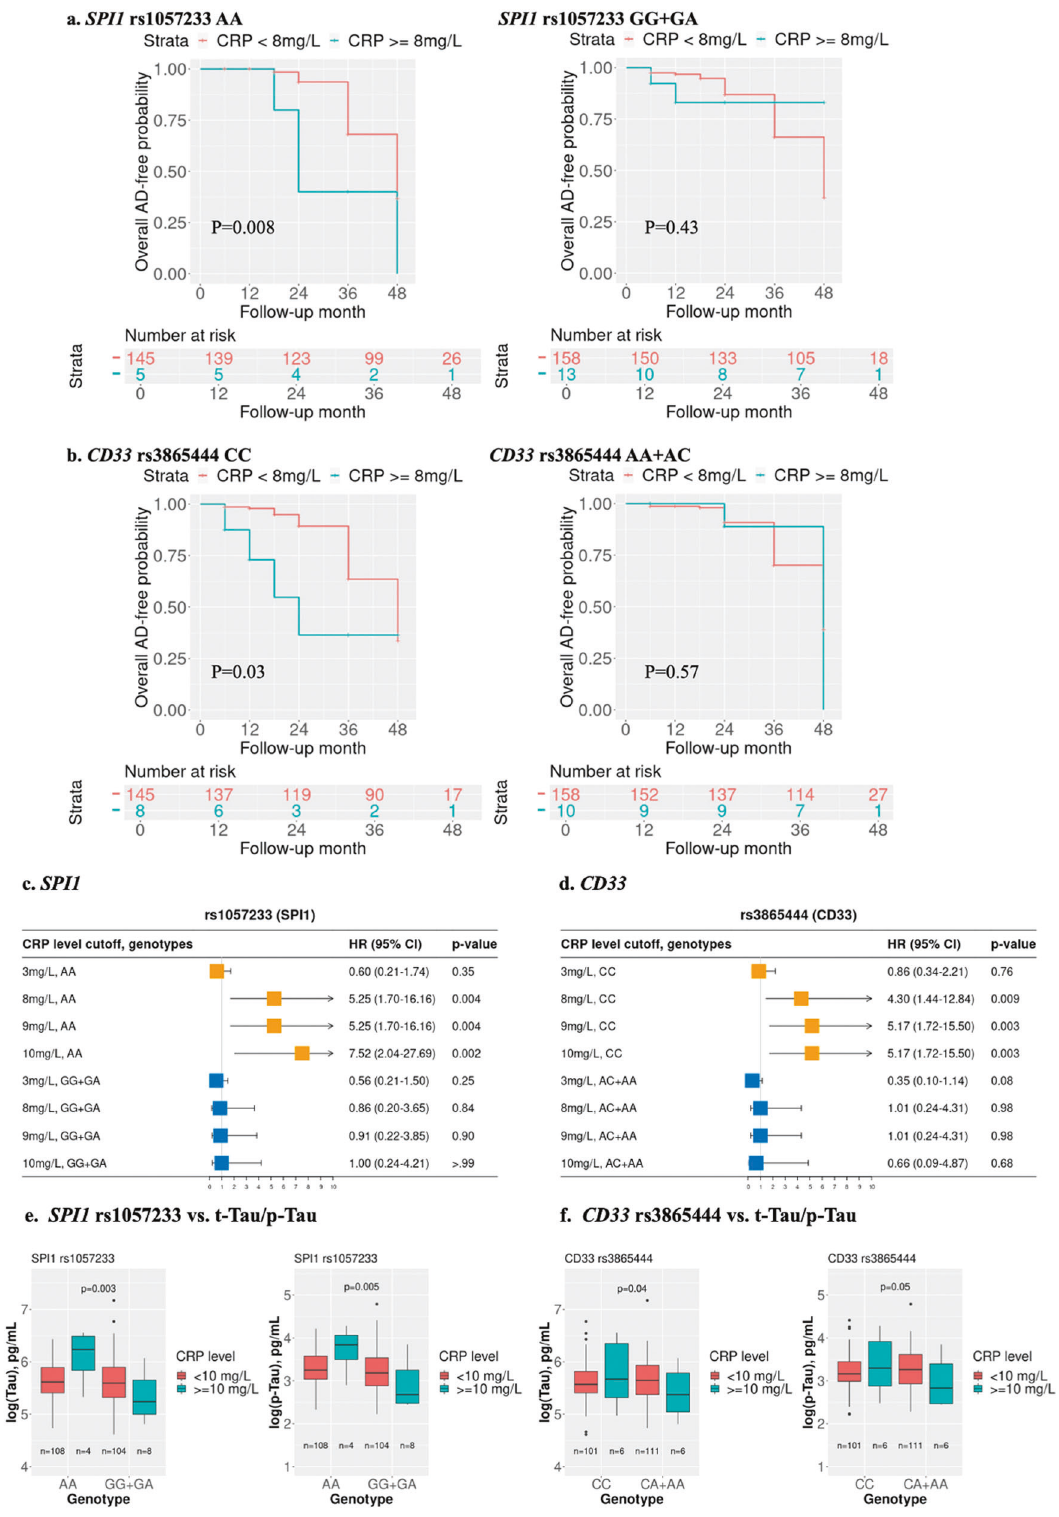
for the in vivo diagnosis of AD, as recently proposed in the amyloid-tau-neurodegeneration (A/T/N) framework [39]. Further analyses of individuals with these genotypes showed